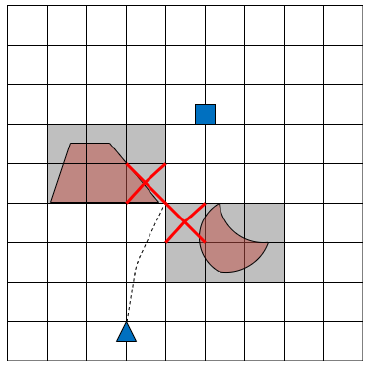
Figure 5. The planner suffers from infinite-loop.